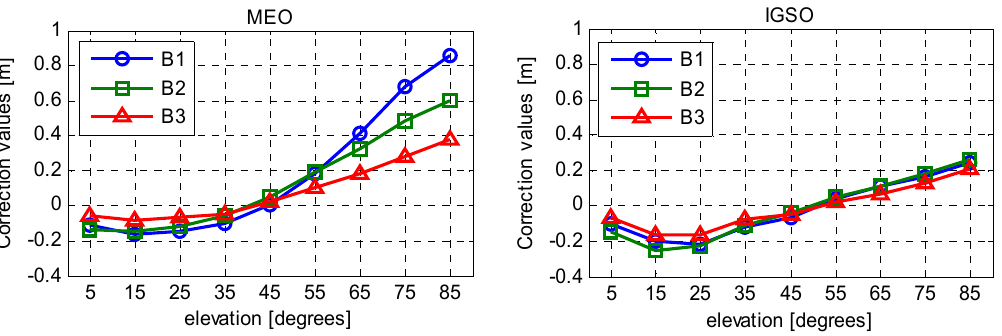
Figure 6. Suggested correction values of code bias (orbit type-, frequency-, and elevation-dependent).